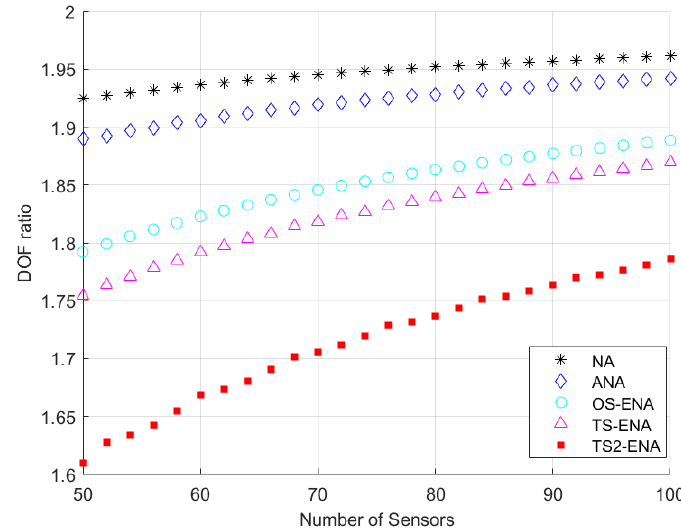
Figure 6. DOF ratio vs. number of sensors.